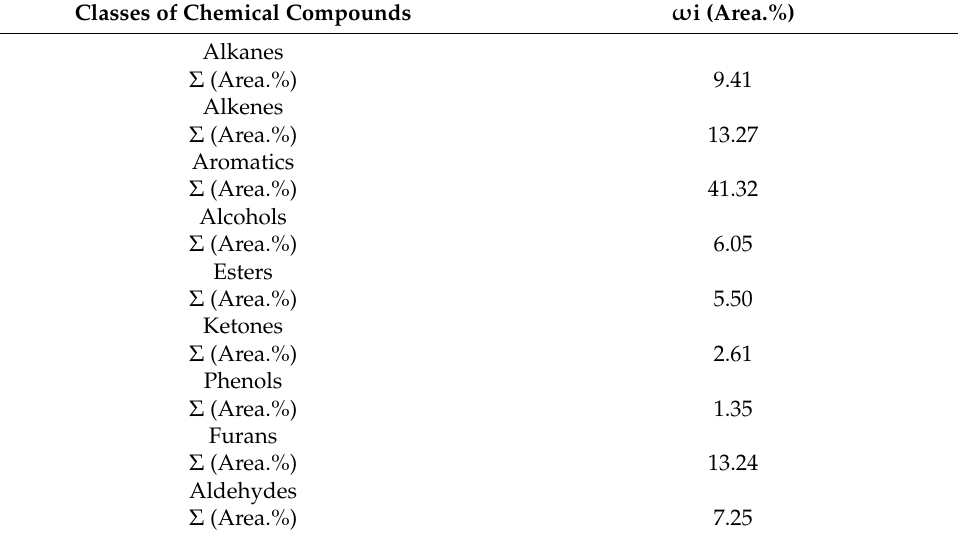
Figure 13. Chromatograms of bio-oil in pilot scale and distillation fractions. Table 10. Classes of compounds and summation of peak areas of hydrocarbons and oxygenates identified by CG-MS in gasoline-like fraction (40–175 ◦ C) after distillation of bio-oil obtained in pilot